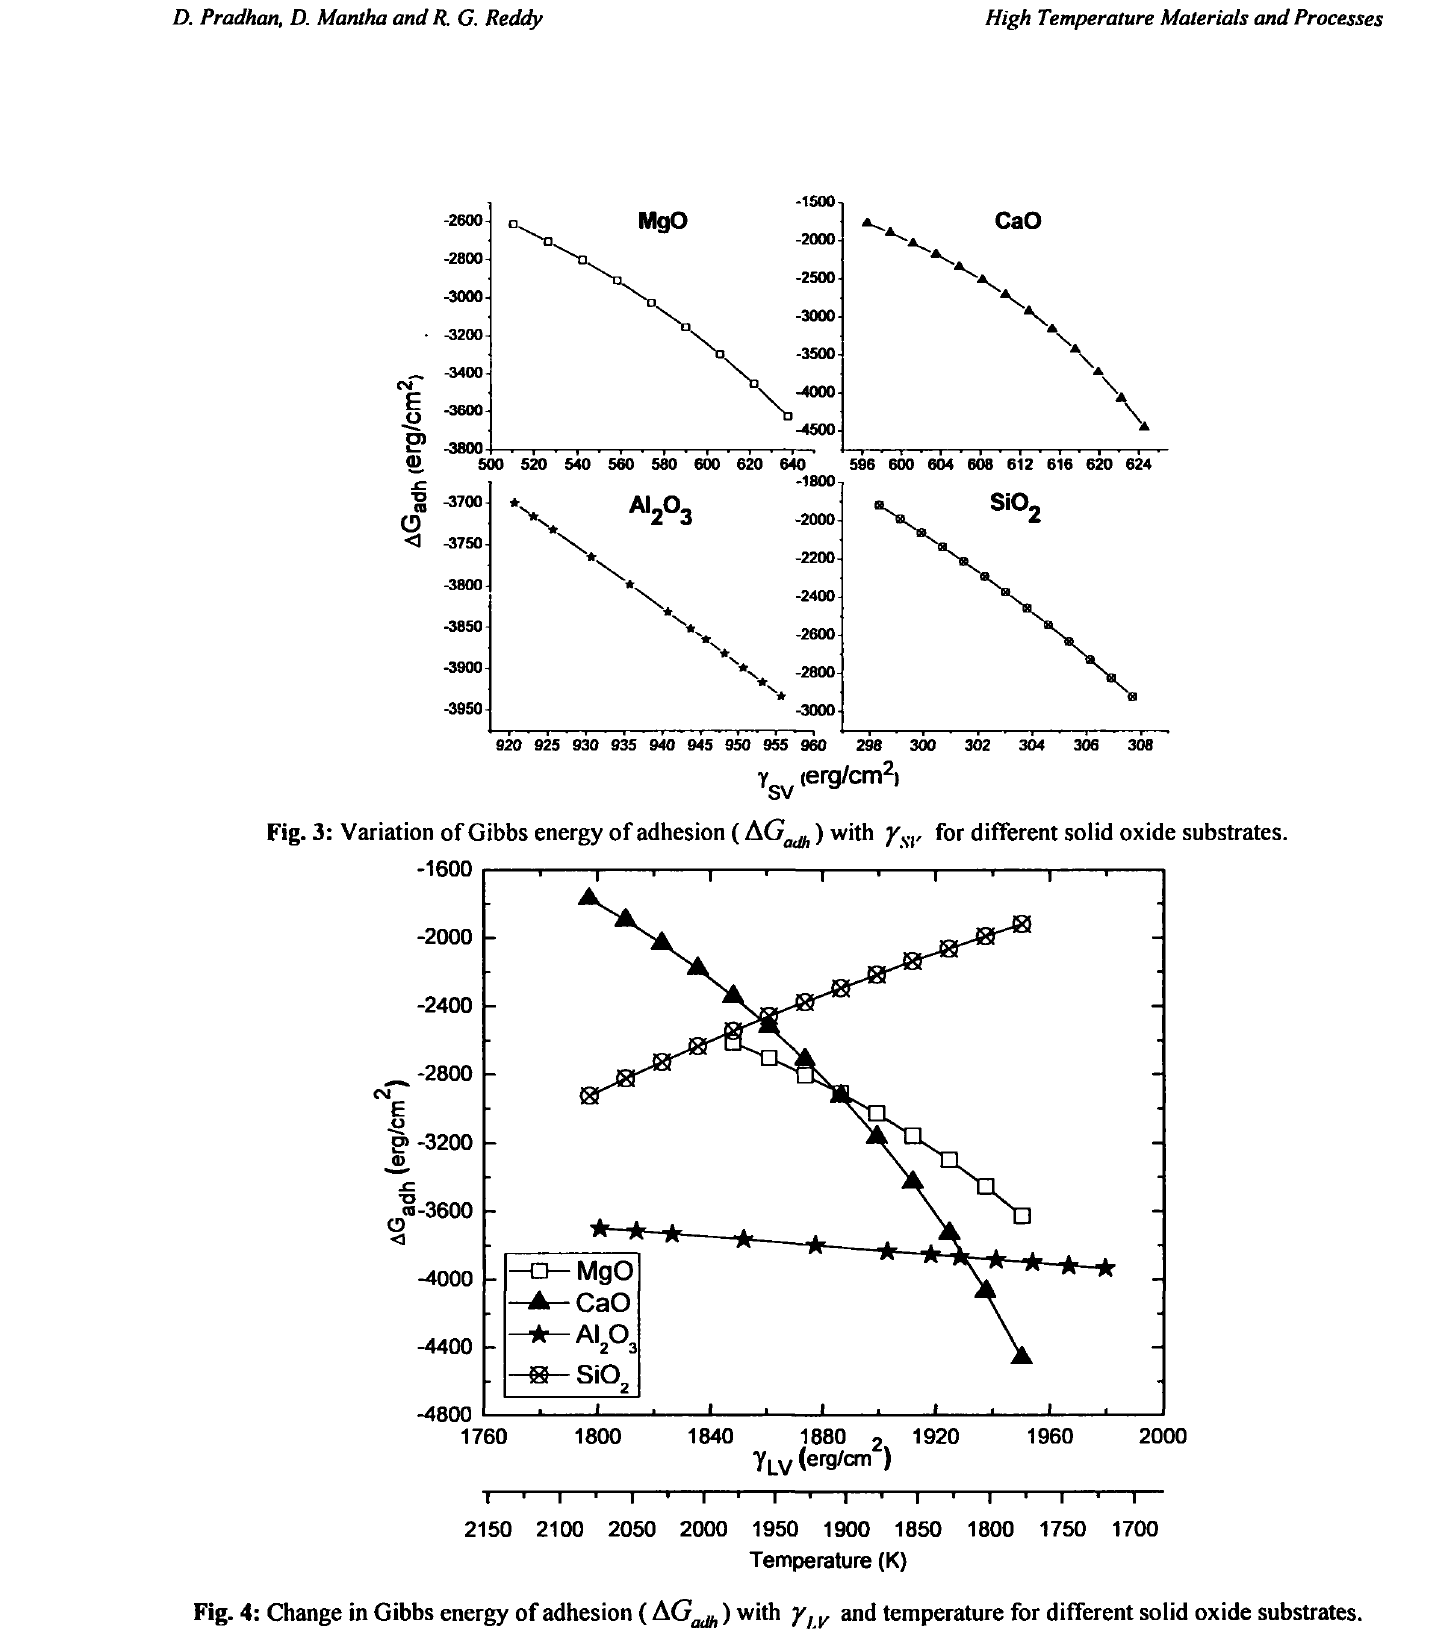
Fig. 4: Change in Gibbs energy of adhesion ( &G